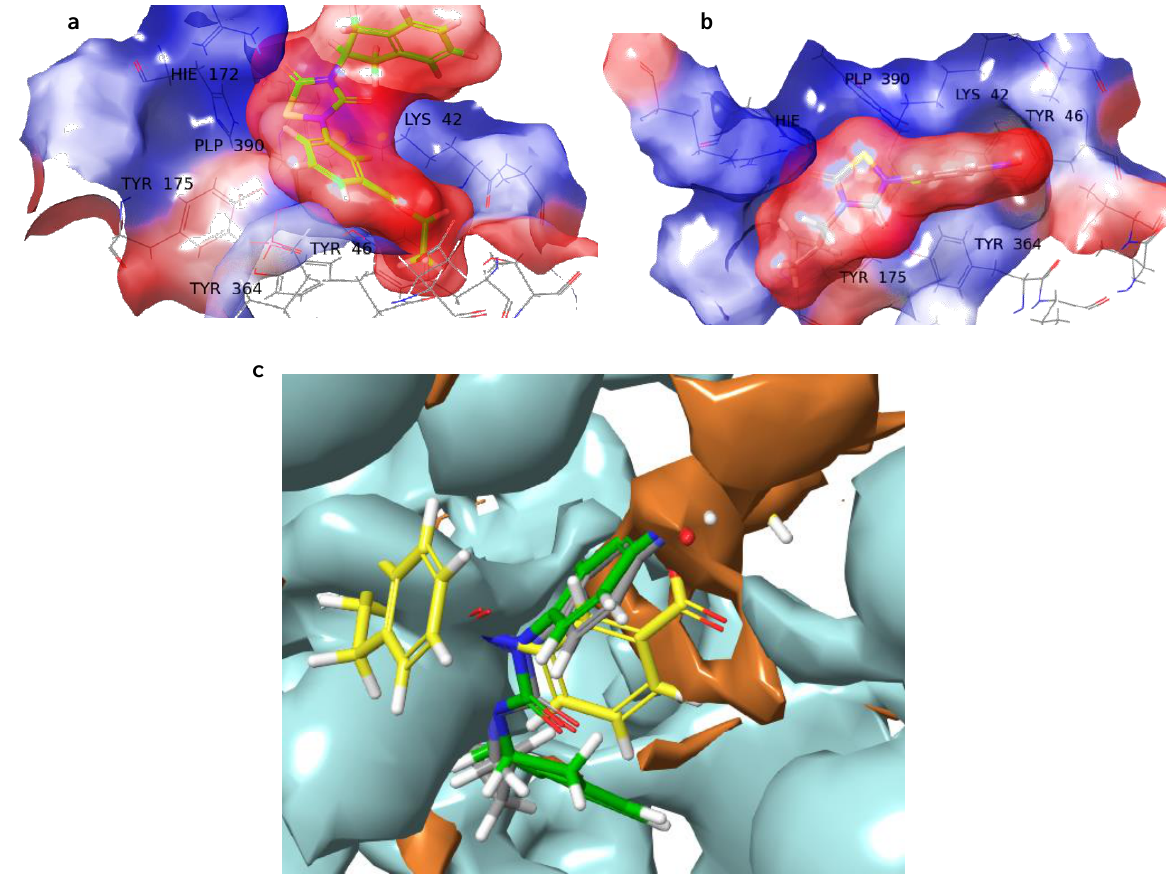
Figure S3. Surface electrostatic potential of inhibitors (a) Surface electrostatic potential of inhibitors 21 and (b) 25 . (c) Hydrophobic and hydrophilic map of inhibitors 19 (green), 21 (yellow) and 25 (grey) generated into the binding pocket of Mycobacterium tuberculosis AlaR enzyme (PDB ID: